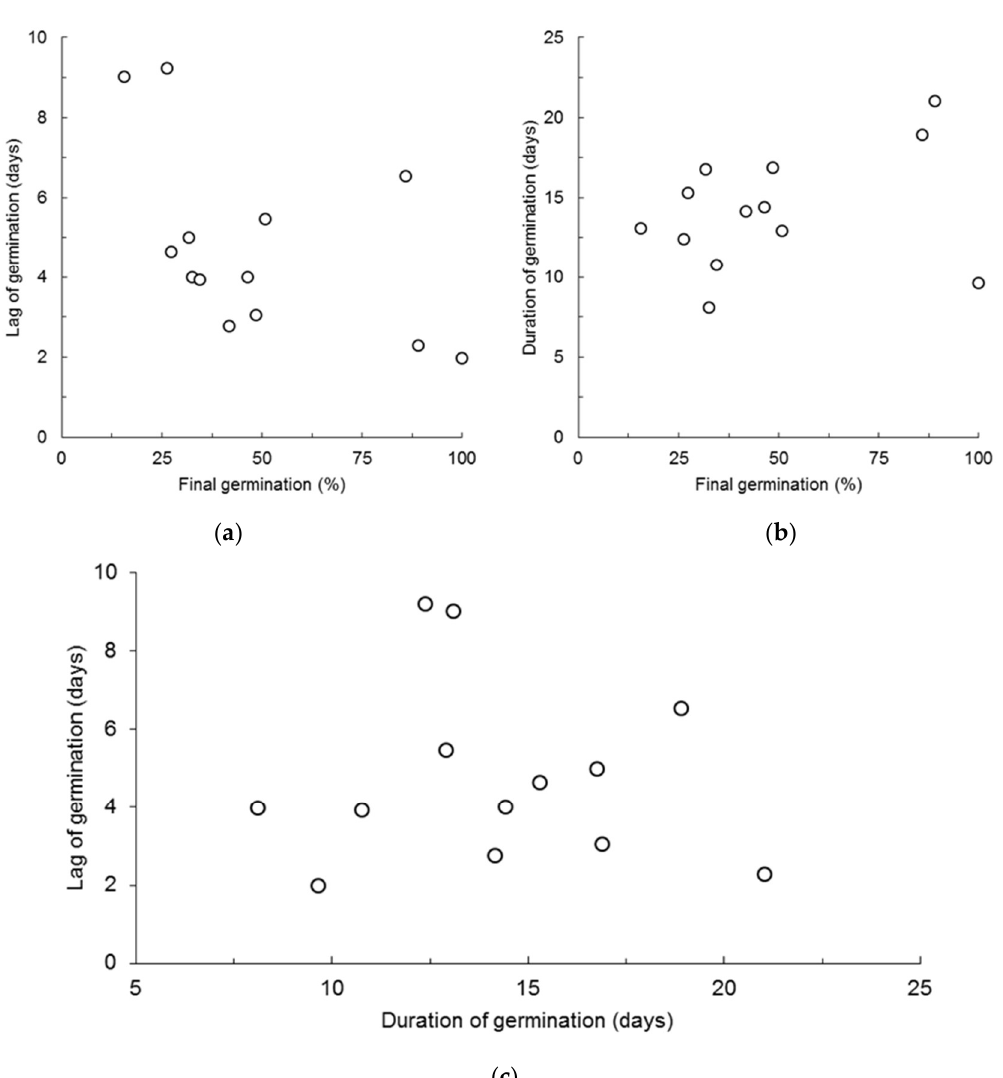
Figure 2. Biplots of: ( a ) final germination and time needed for the start of germination (lag); ( b ) final germination and time needed to the completion of germination minus the lag of germination (duration); ( c ) lag and duration of germination.